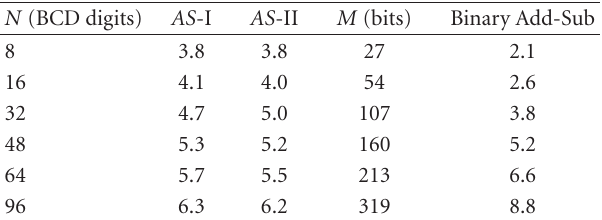
Table 4: Delays in ns for decimal and binary adder-subtractor in Virtex-5 -2.